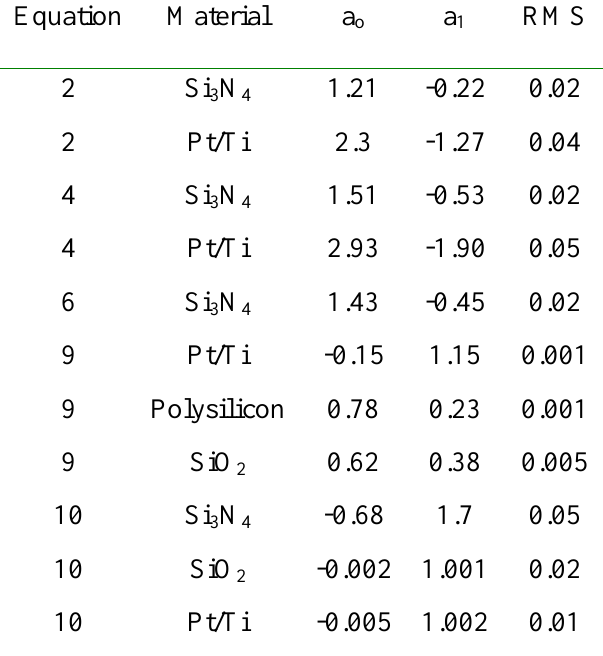
Table 3. A list of linear equations constants and the average RMS of curve fitting